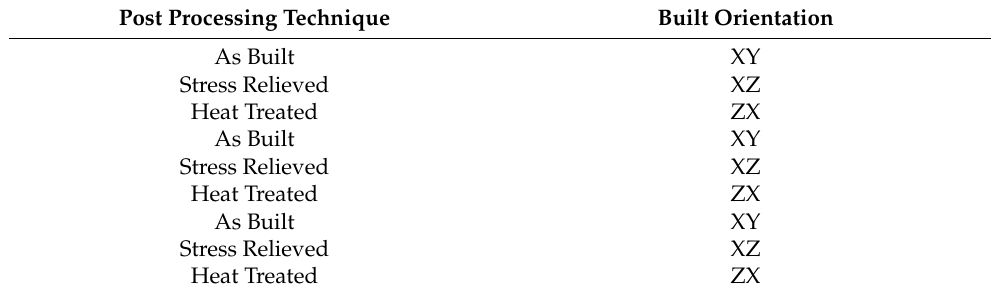
Table 1. Experiments Design [22].